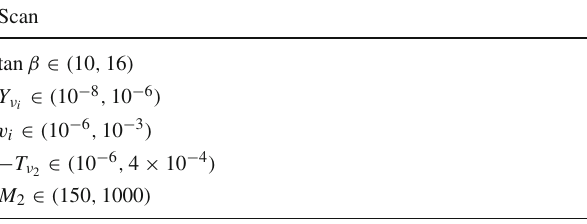
Table 2 Range of low-energy values of the input parameters that are varied in the scan, where Y ν , v i , T ν and M 2 are log priors while tan β is i 2 a flat prior. The VEVs v i , and the soft parameters T ν and M 2 , are given 2 in GeV. The GUT-inspired low-energy relation M 2 = 2 M 1 is assumed